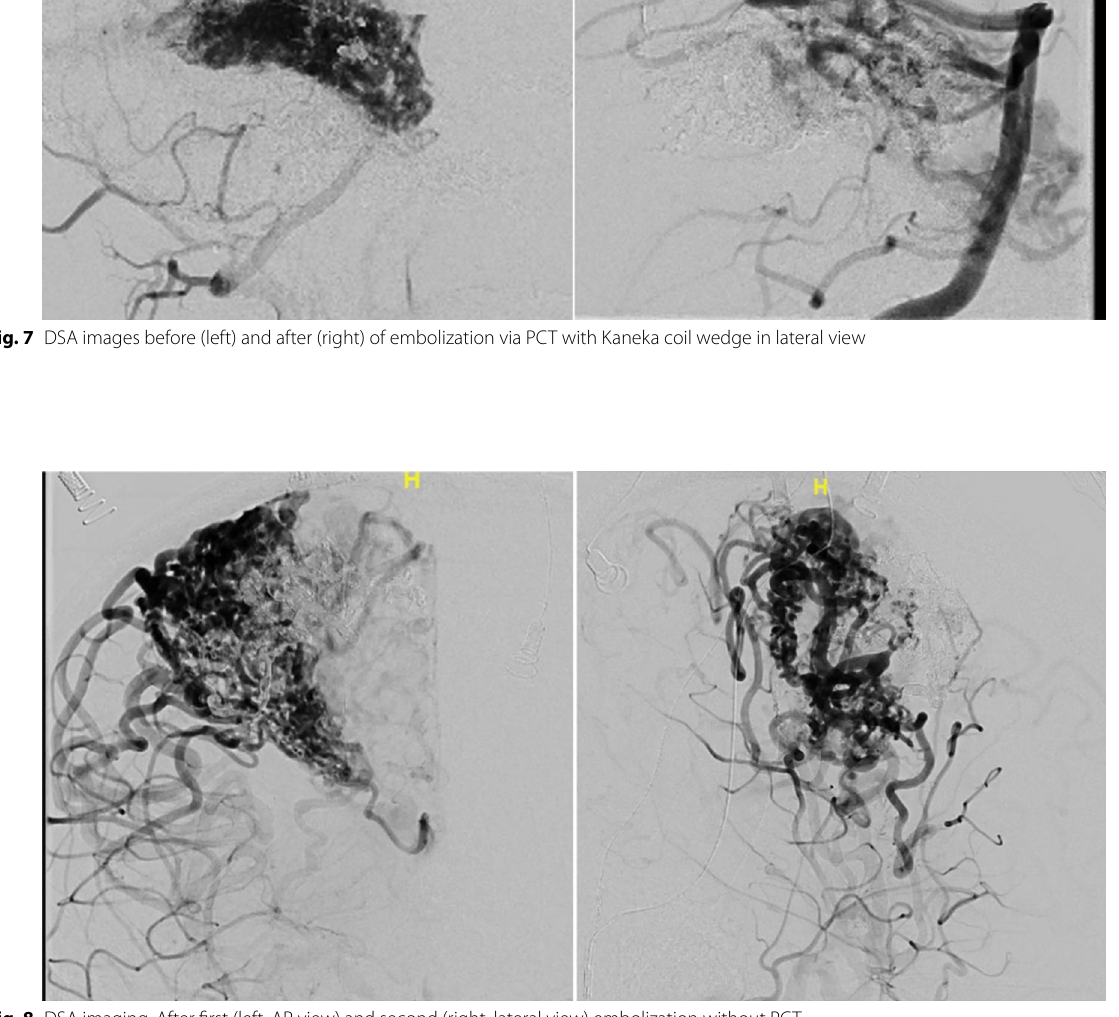
Fig. 8 DSA imaging. After first (left, AP view) and second (right, lateral view) embolization without